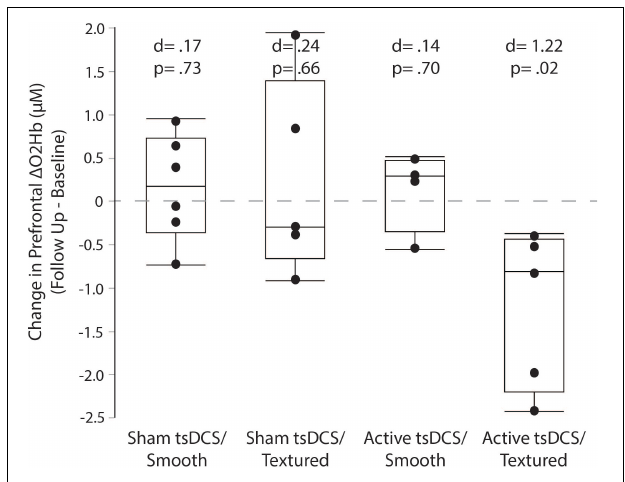
FIGURE 9 | Prefrontal cortical activity measured by fNIRS. Box plots showing the change in prefrontal fNIRS between the baseline and follow-up visits. For each participant, all trials were averaged within each session before calculating the change as follow-up minus baseline. Only the active/textured group showed a significant reduction in prefrontal activity at follow-up. Lower prefrontal activity suggests fewer executive control resources are needed to perform the complex terrain